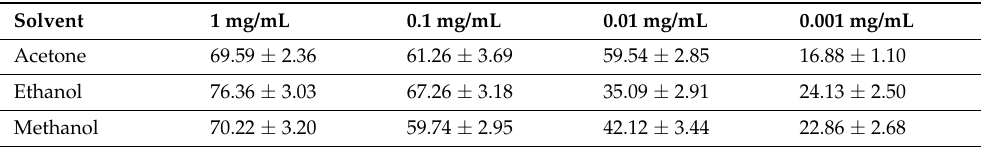
Table 4. Antiproliferative activity of Coronopus didymus extracts (mean ± standard deviation) on HepG2 cell line.